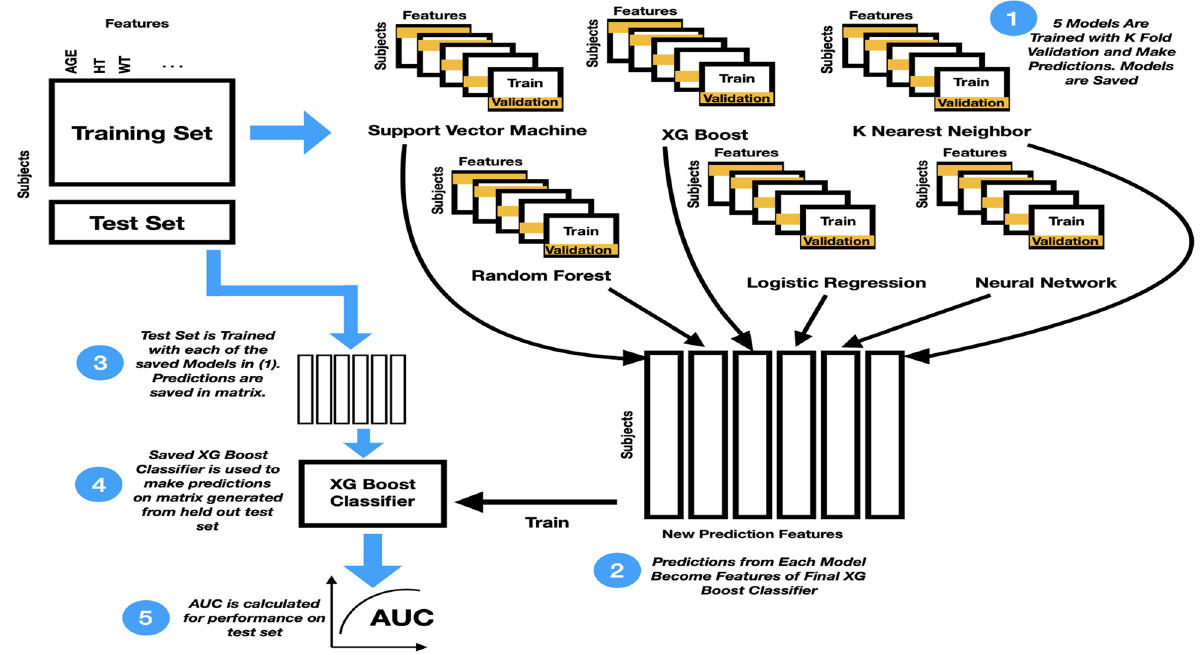
Figure 1. This is the pipeline used to train the machine learning models and generate predictions. The training set is sent through fivefold training for each model type to generate a prediction for each training sample. These predictions are then used to train a higher level model to predict a final outcome given the predictions from the fivefold training. Each of the 6 models from each fold then predicts on the held out test set and the average prediction for the probability of depression is stored. The higher level model then makes final predictions on the held out test